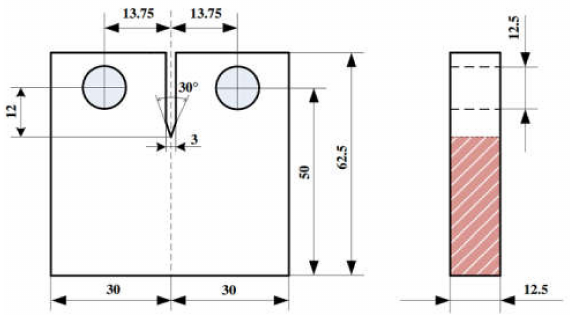
Figure 5. The size of fatigue crack growth (CT) specimen (units: mm)